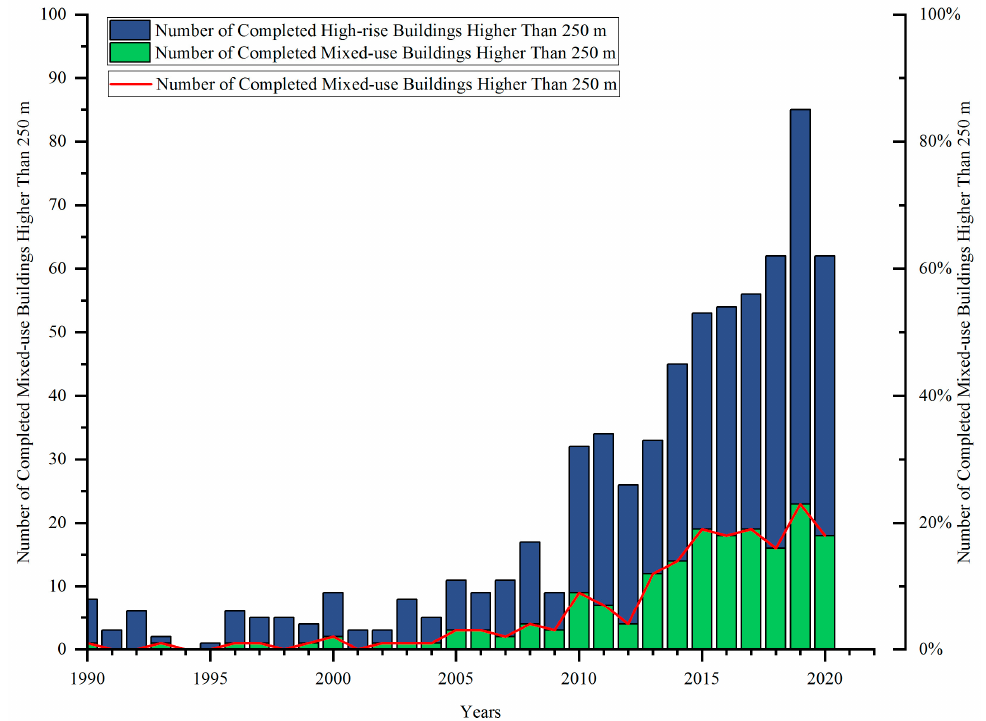
Figure 1. Number of completed high-rise buildings higher than 250 m and Variation of the proportion of mixed-use buildings in high-rise buildings.